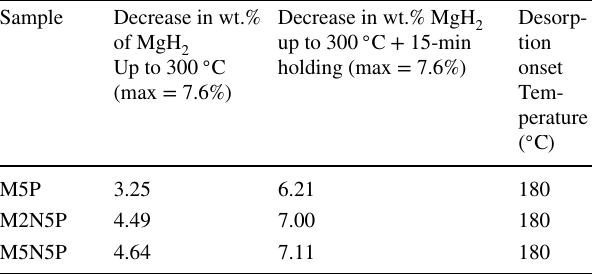
Table 5 The results of TGA analysis on the M5P, M2N5P, and M5N5P samples